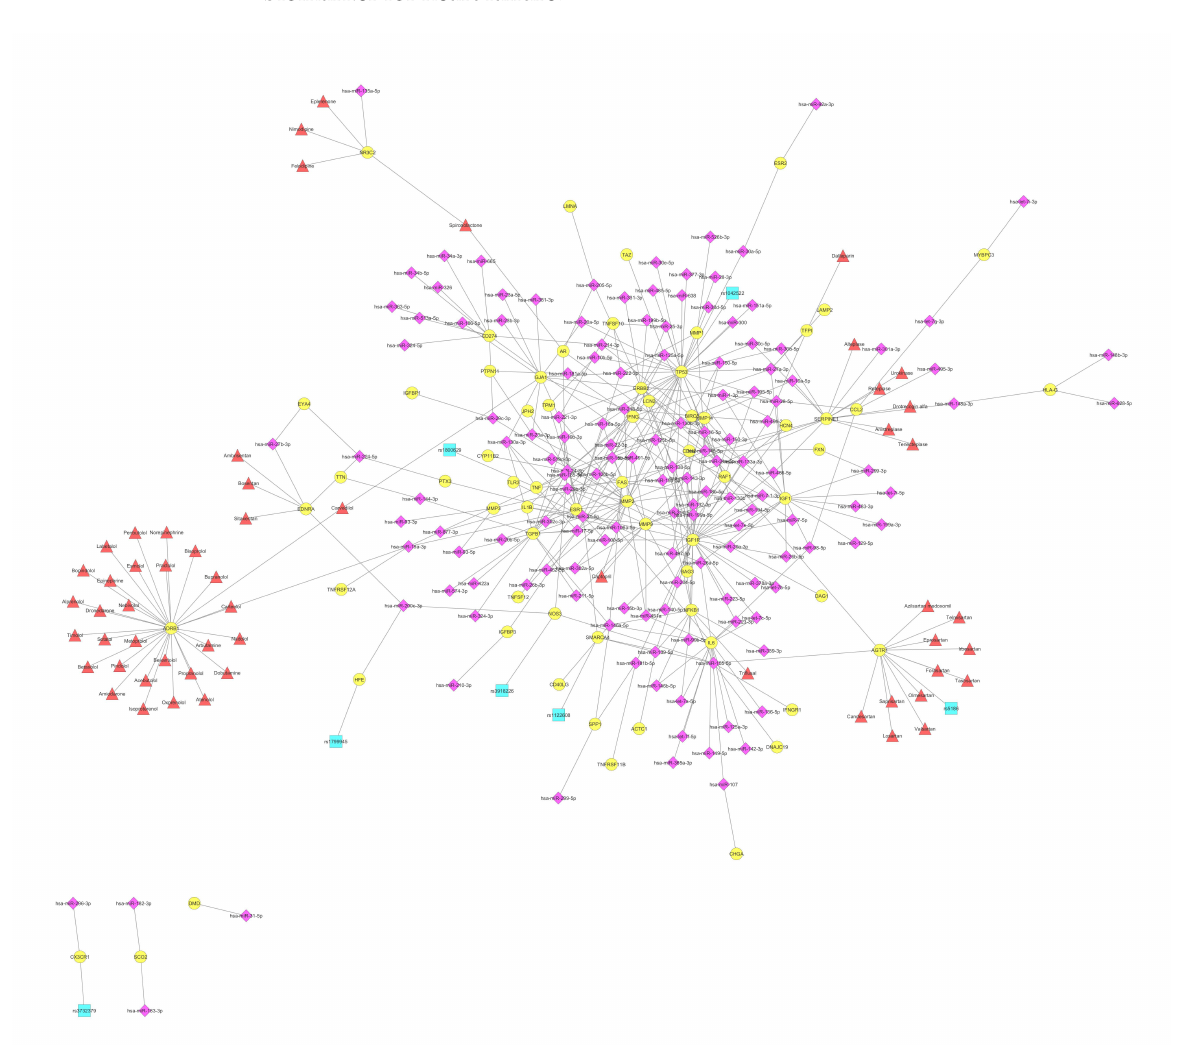
Figure 4. Network of VTGs enriched within the DOSE term cardiomyopathy. The network displays 67 cardiomyopathy-associated VTGs (circles in yellow), as well as 145 miRNAs (diamonds in purple), seven SNPs (squares in turquoise) and 56 drugs (triangles in red) that are associated with CVD, and which target and/or affect it. The network was created using Cytoscape